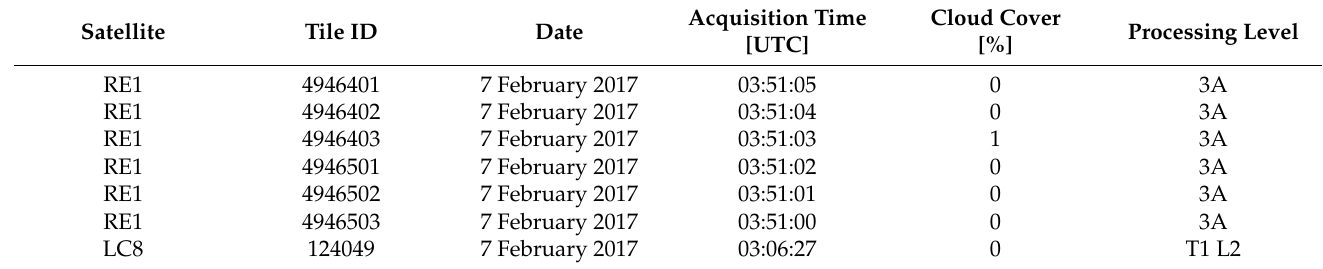
Table 1. Validation data.